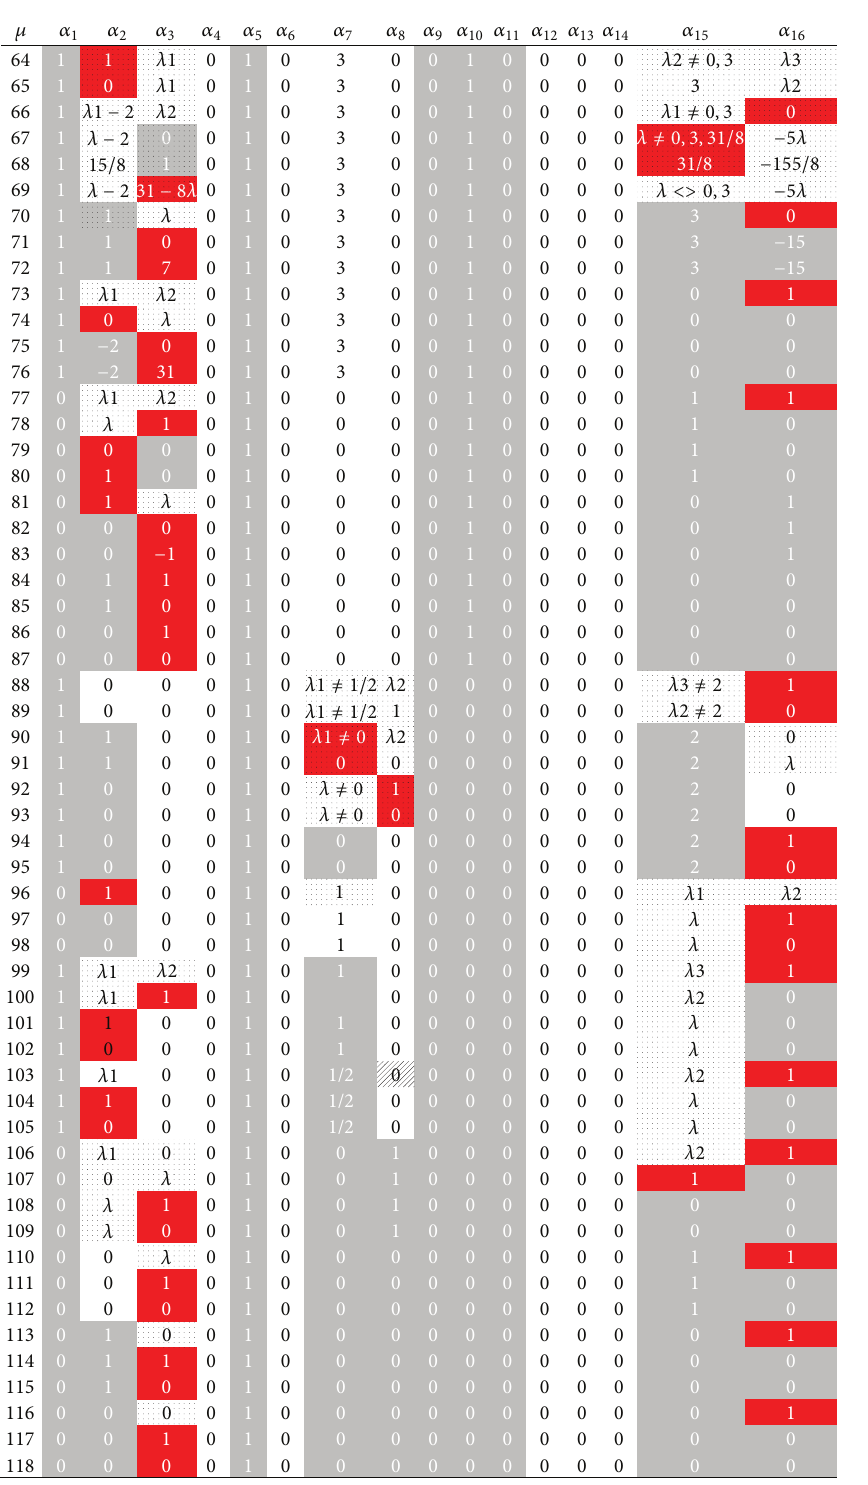
Figure 5: Case B.2.1: 𝛼 11 = 0 , 𝛼 9 = 0 , 𝛼 5 ̸=0 ; classification of the QFLA of dimension